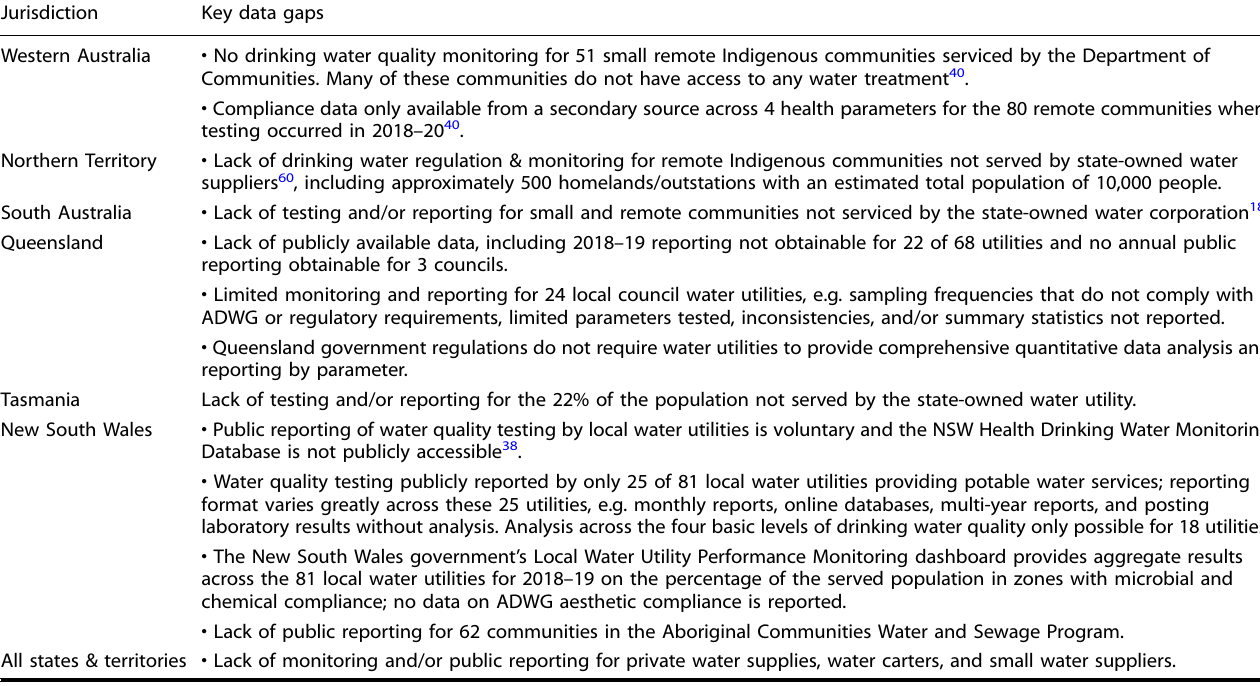
Table 7. Summary of key data gaps in 2018/19 for public reporting of drinking water quality in Australian states/territories. Jurisdiction Key data gaps